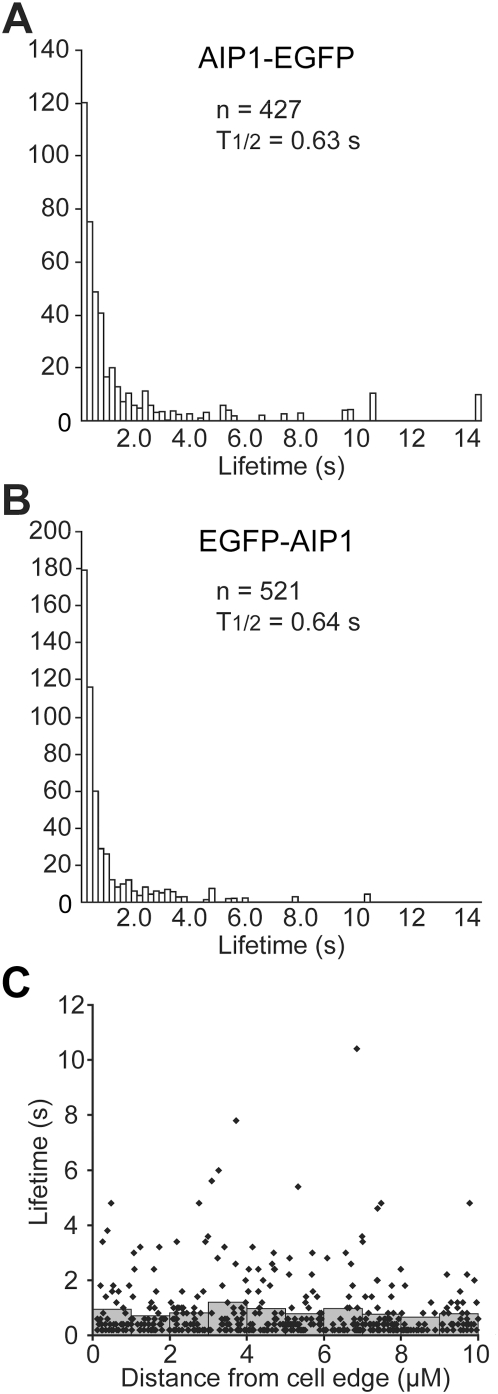
Lifetime distribution of single-molecule AIP1 speckles in lamellipodia.(A and B) Speckle images in lamellipodia of XTC cells expressing a low amount of EGFP-AIP1 or AIP1-EGFP were acquired at intervals of 200 ms. The graphs show speckle lifetime distribution of AIP1-EGFP, n = 427, 1 cell (A) and EGFP-AIP1, n = 521, 1 cell (B), respectively. A representative result from 3 measurements is shown for each construct. Speckles with single EGFP intensity which appeared over the course of a 3 s time window were followed. Columns show the number of speckles with indicated lifetime after normalization for photobleaching. The decay rate is expressed as half-life (T1/2) which was calculated by fitting the lifetime data between 0.4 and 3 s with a single exponential. The dissociation rate of AIP1 is faster than that of capping protein (T1/2 = 1.20–1.23 s) observed previously [12]. (C) Lifetime versus position plot of AIP1 speckle lifetime data. Dots indicate lifetime and emerging position of individual EGFP-AIP1 speckles. Gray columns, the average speckle lifetime in each indicated area after normalization for photobleaching.